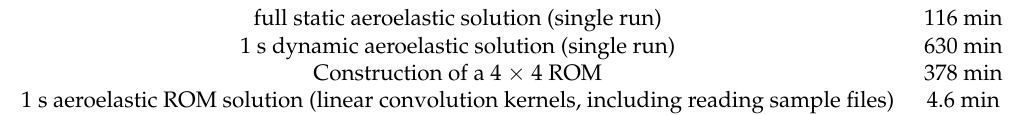
Table 7. Approximate computational time for various solution techniques (Intel Core i7-7700